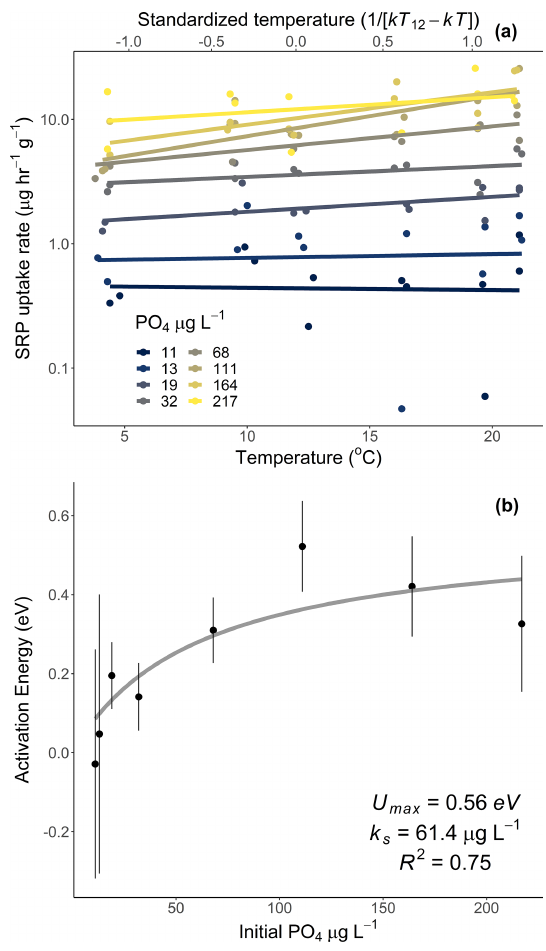
Figure 2. Rates of soluble reactive phosphorus (SRP) uptake com- pared to temperature for Acer rubrum leaves incubated at different temperatures and initial concentrations of SRP (a) . The secondary x axis in (a) represents the standardized Boltzmann temperature, and the y axis is log 10 -scaled. Slopes of the lines in (a) represent the activation energy of SRP uptake at different SRP concentrations. Figure 3. Uptake rates of soluble reactive phosphorus (SRP) across